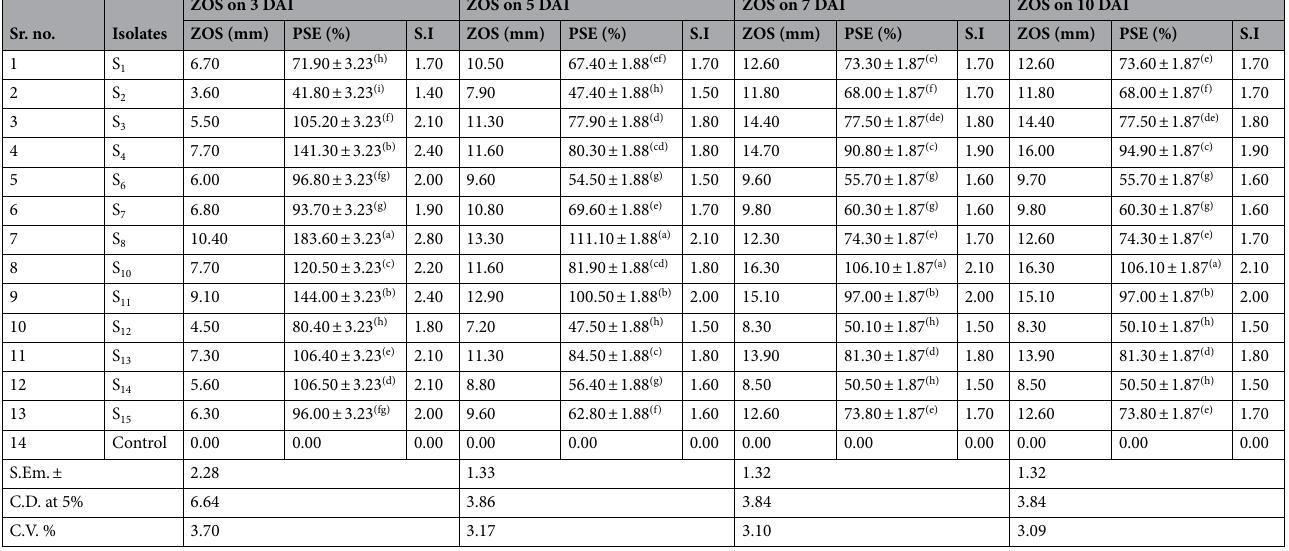
Table 6. Phosphate Solubilization Efficiency (PSE) of isolates on TCP media during 3, 5, 7 and 10 DAI. PSE phosphate solubilization efficiency, ZOS zone of solubilization, S.I . solubilization index. Values of PSE (%) are mean ± standard error of 3 replicates. Different letters at various points indicate significant difference between treatments using Duncan’s multiple range test (P ≤ 0.01).